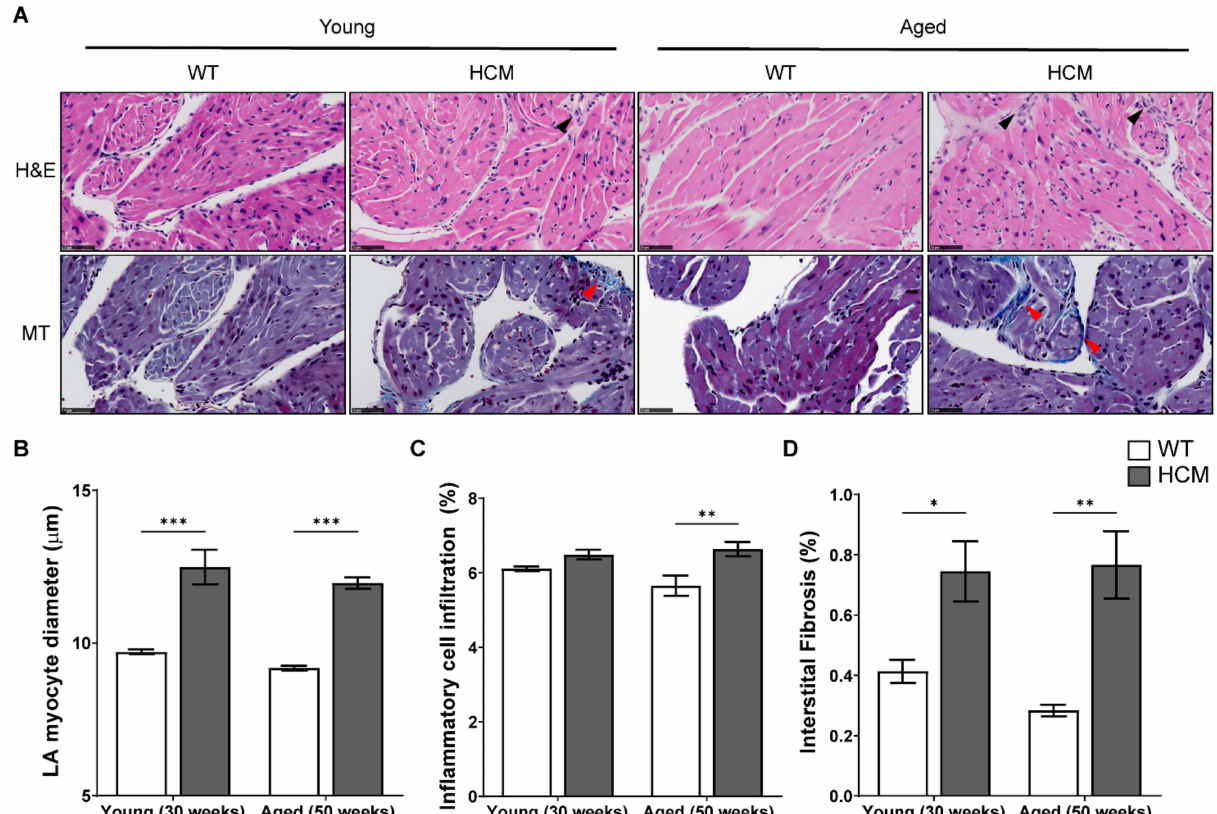
Figure 3. HCM mouse atria demonstrates myocyte hypertrophy, elevated inflammatory cell infiltrates, and interstitial fibrosis. ( A ) Representative photomicrographs of transverse sections of the LA stained with hematoxylin and eosin (H&E; top) and Masson’s trichrome (MT; bottom) in young and aged HCM mice demonstrated increased inflammatory cell infiltration (black arrowheads) and interstitial fibrosis (stained blue; red arrowheads) in the atrial myocardium as compared to controls. Scale = 50 µ m. ( B ) Pooled data on LA cardiomyocyte diameter, ( C ) inflammatory cell infiltrate, and ( D ) atrial fibrosis across six independent animals per group. No significant age differences were observed. * p < 0.05, ** p < 0.01 and *** p <